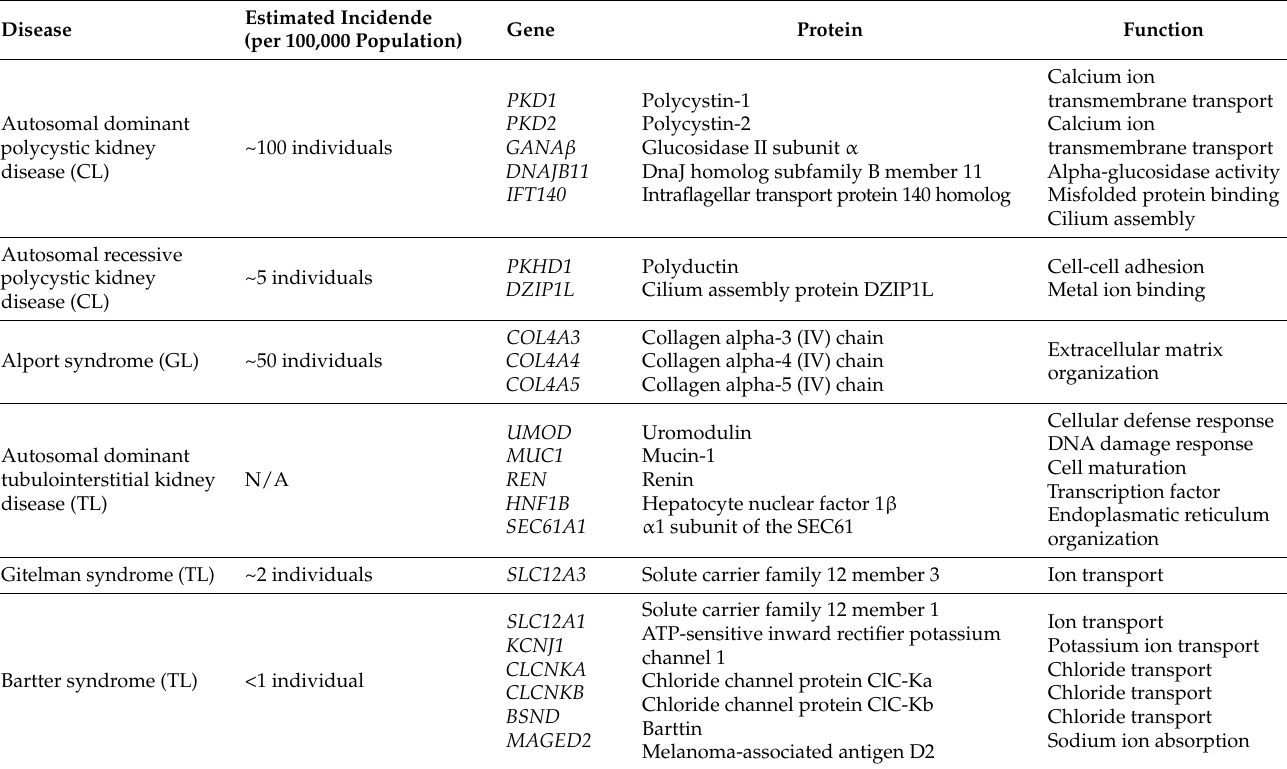
Table 1. List and classification of Genetic kidney diseases reviewed in the